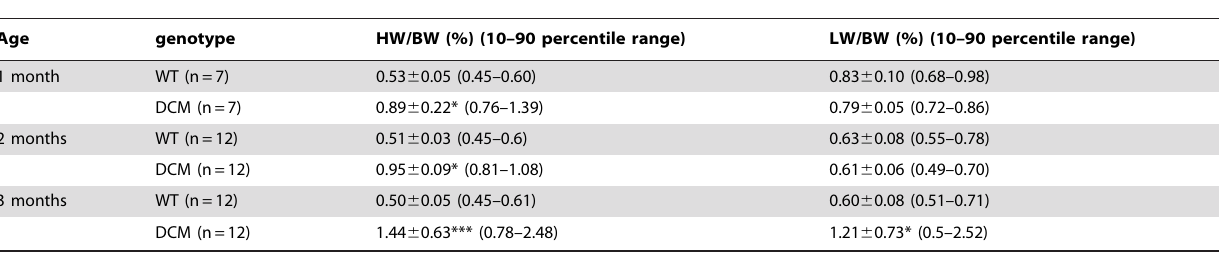
Table 1. Averages and ranges of HW/BW and LW/BW ratios in individual WT and DCM mice at 1, 2, and 3 months of age.